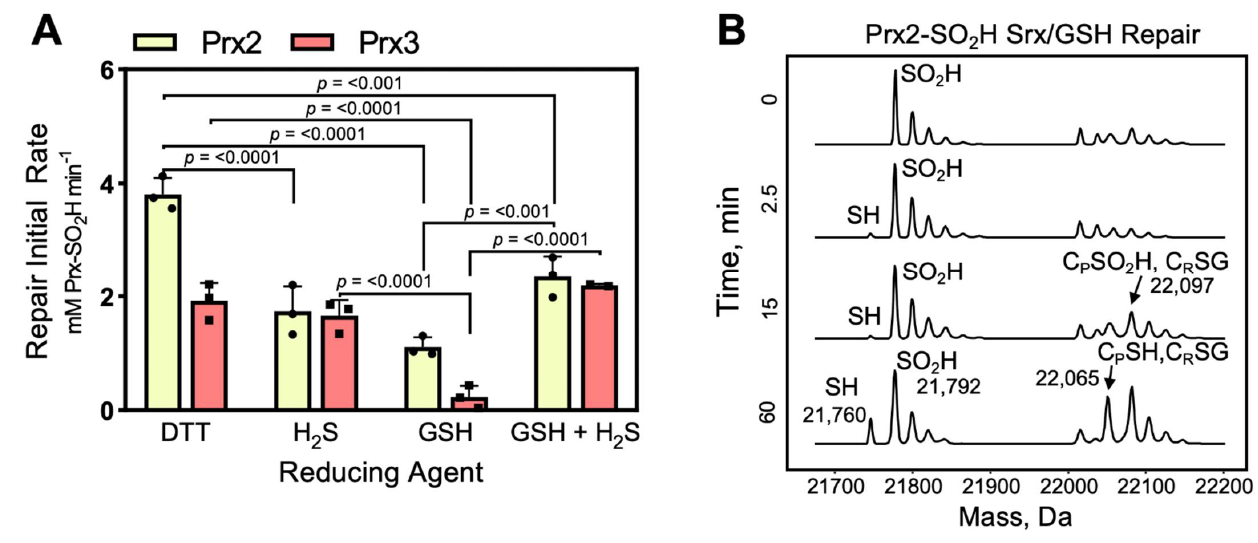
Figure 6. Kinetic study of the repair of hyperoxidized human Prx2 and Prx3 by Srx using chemical and biological reductants. ( A ) Summary bar graph presentation of the rates of Prx-SO 2 H reduction catalyzed by Srx in the presence of DTT, H 2 S, GSH, and combined H 2 S, GSH. Time course data were collected by ESI-TOF MS analysis, and the reaction rates were calculated by fitting the initial decrease in Prx-SO 2 H to a linear equation ( n = 3). Data shown as ± standard deviation (SD). ( B ) ESI-TOF MS spectra of Prx2-SO 2 H repair by Srx with GSH, showing accumulation of glutathionylated Prx2 over time.